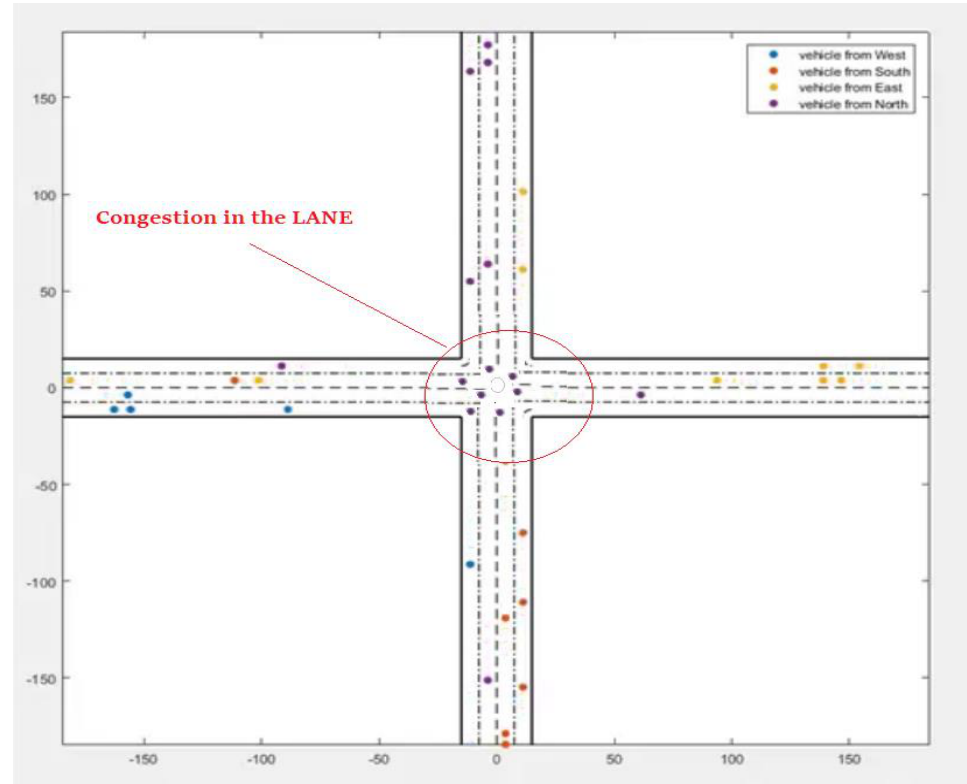
Figure 10. Vehicle moving on forward and backward over multiple lanes (traffic congestion).